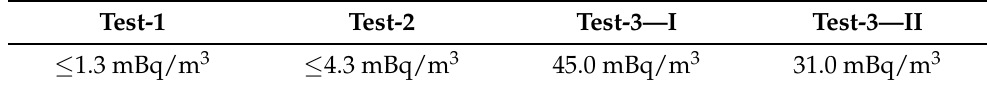
Table 3. Activity Rn measured with ERM for the Tests.